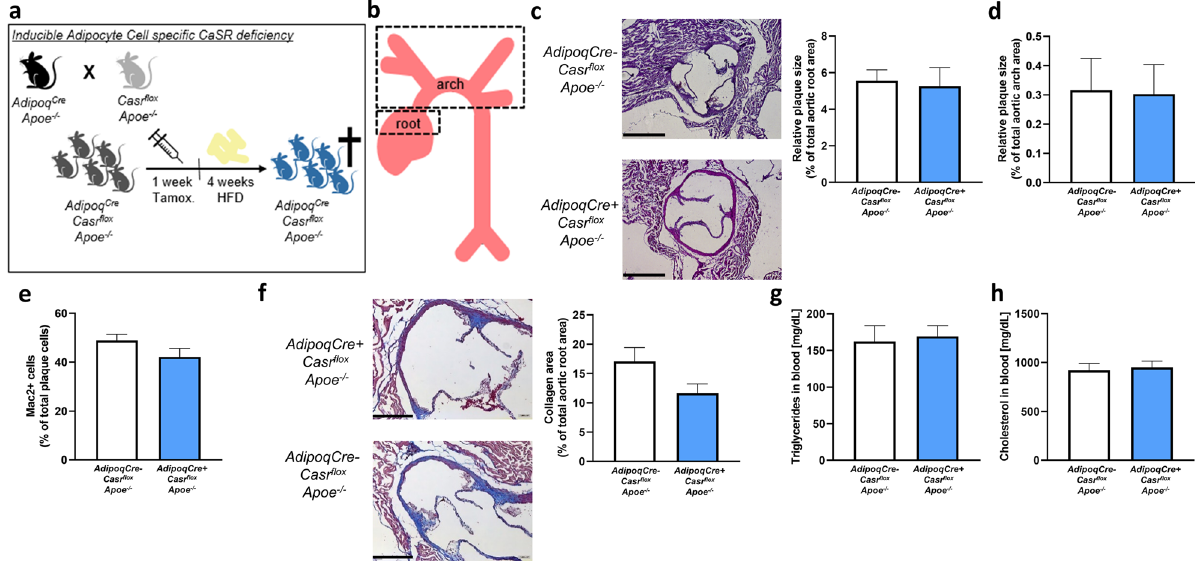
Figure 1. Adipocyte specific CaSR deficiency does not influence early atherosclerotic lesion development. ( a ) Representation of the experimental workflow. Mice were crossed and offspring were injected with tamoxifen and fed a HFD for 4 weeks before analysis. ( b ) Schematic representation of the areas that were used for analysing atherosclerotic plaques. ( c ) Representative images and quantification of aortic root lesions in both AdipoqCre− Casr flox Apoe −/− and AdipoqCre + Casr flox Apoe −/− mice (n = 10–12). Scale bar 500 µm. ( d ) Quantification of aortic arch lesions in AdipoqCre− Casr flox Apoe −/− and AdipoqCre + Casr flox Apoe −/− mice (n = 10–15). ( e ) Quantification of macrophage content of aortic root lesions in AdipoqCre− Casr flox Apoe −/− and AdipoqCre + Casr flox Apoe −/− mice (n = 11–13). ( f ) Images to represent the presence of collagen in aortic root lesions and quantification in AdipoqCre− Casr flox Apoe −/− and AdipoqCre + Casr flox Apoe −/− mice (n = 11–12). Scale bar 250 µm. ( g , h ) Quantification of plasma triglycerides ( g ) and cholesterol ( h ) levels of AdipoqCre− Casr flox Apoe −/− and AdipoqCre + Casr flox Apoe −/− mice (n = 10–15). Image processing was done using Image J 1.53 (https:// imagej. nih. gov/ ij/). Bar graphs are representation of mean ±